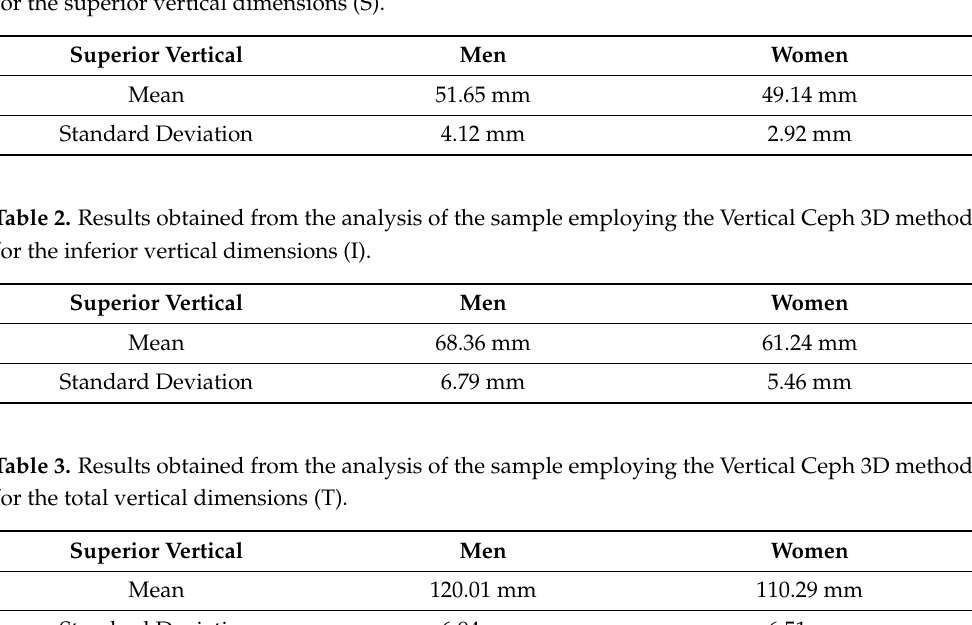
Table 1. Results obtained from the analysis of the sample employing the Vertical Ceph 3D method for the superior vertical dimensions (S).